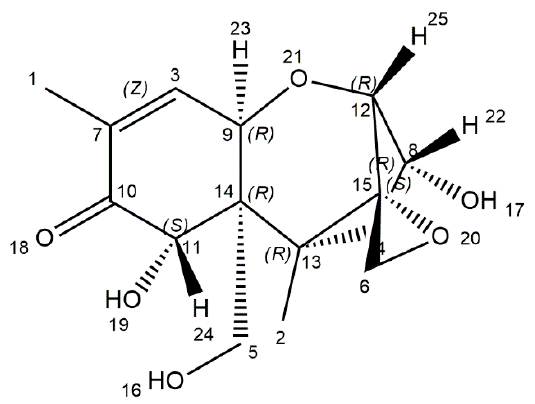
Figure 4. Chemical structure of deoxynivalenol (structure generated from InChI code available